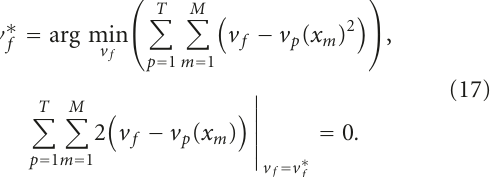
Figure 8: Dual layer scan scenario sample